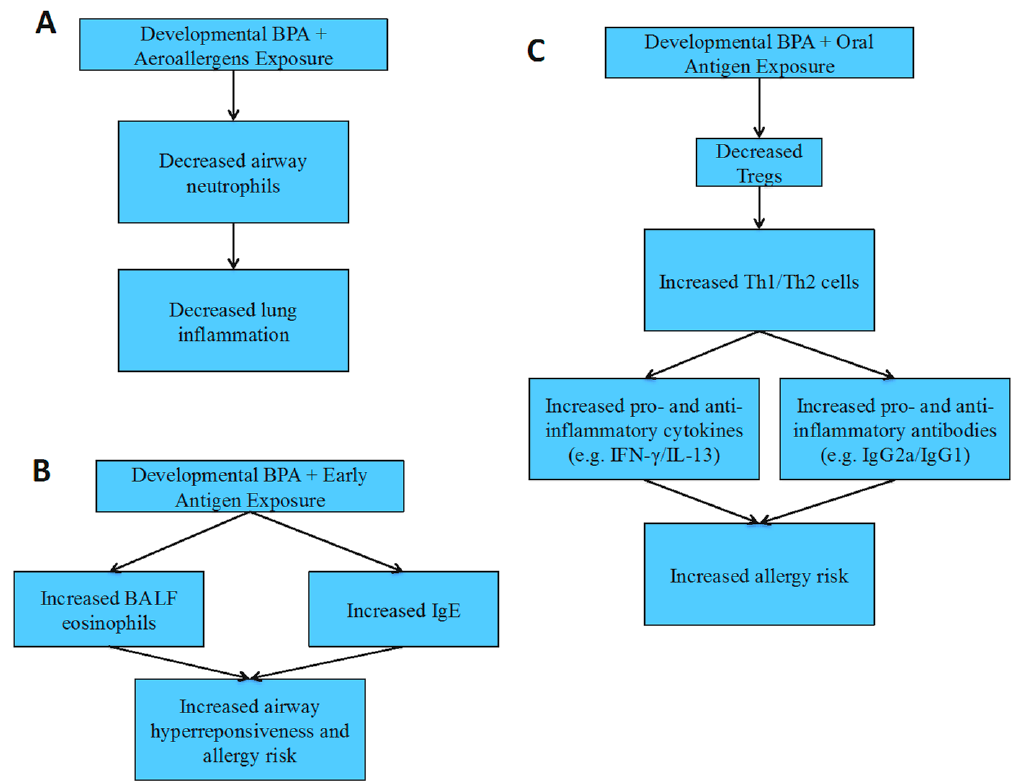
Figure 3. Allergy and asthma risks following developmental bisphenol A (BPA) exposure in male rodents. ( A ) Decreased lung inflammation results from developmental BPA and aeroallergen exposures; ( B ) increased airway hyperresponsiveness and allergy risks result from developmental BPA and early life antigen exposures; ( C ) increased allergy risks result from developmental BPA and oral antigen exposures.